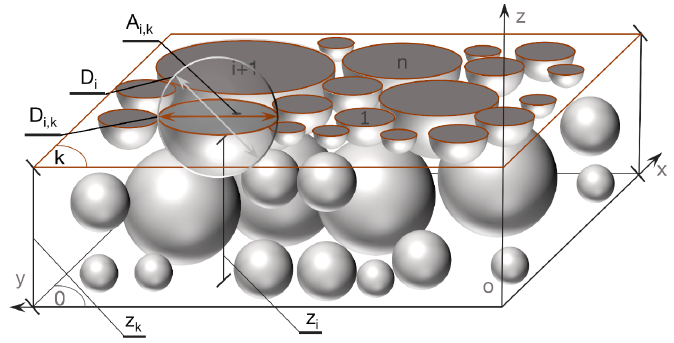
Figure 4. Calculation parameters of generated circle by k-plane across grain matrix.